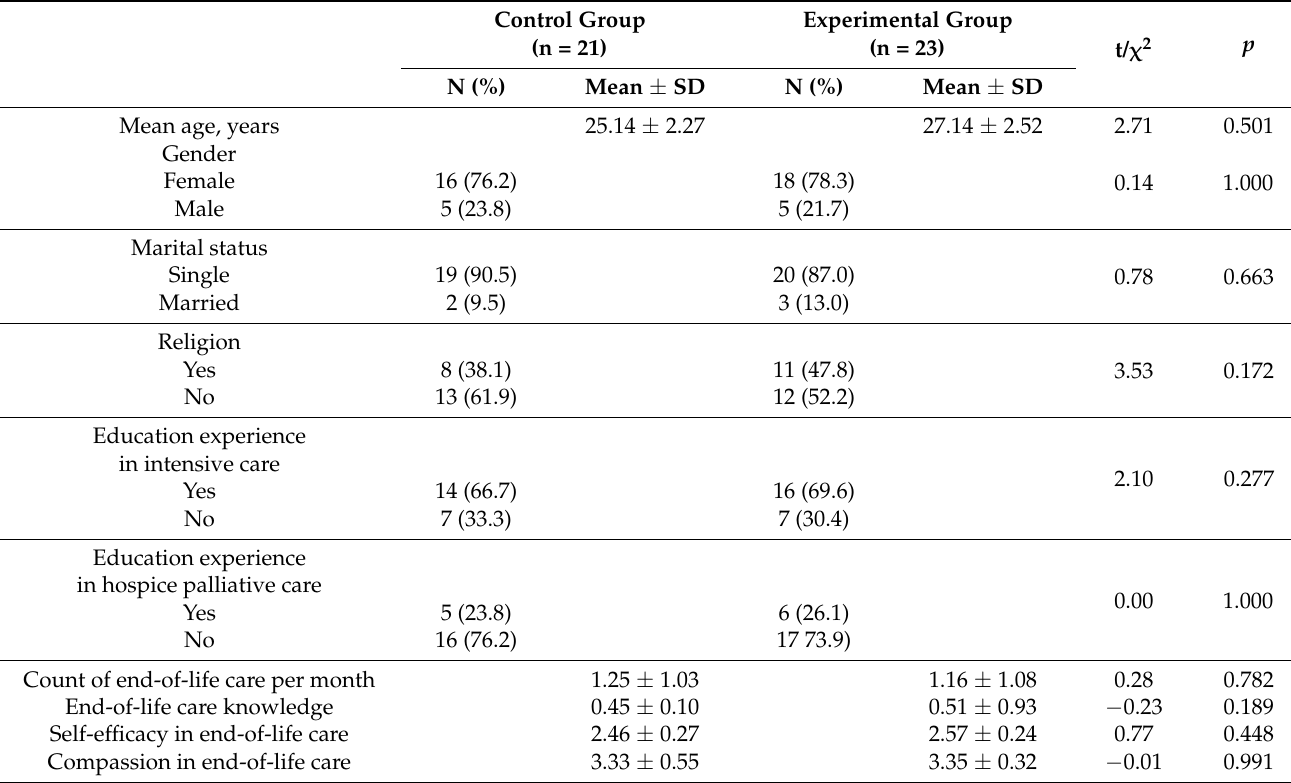
Table 1. General characteristics of the participants and homogeneity between the control group and experimental